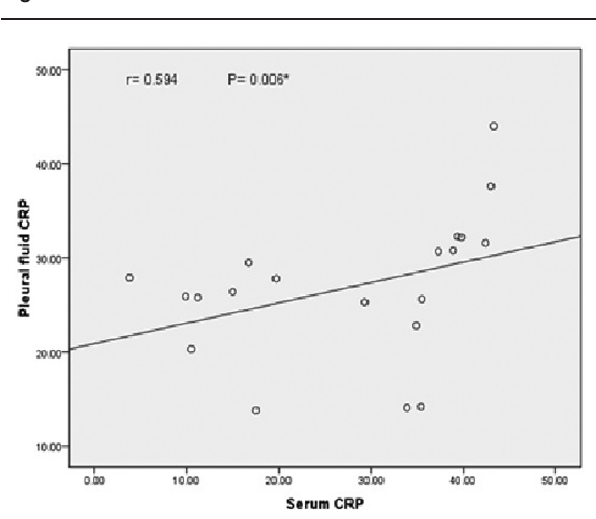
Correlation between serum and pleural C-reactive protein (CRP) levels in malignant pleural effusion.